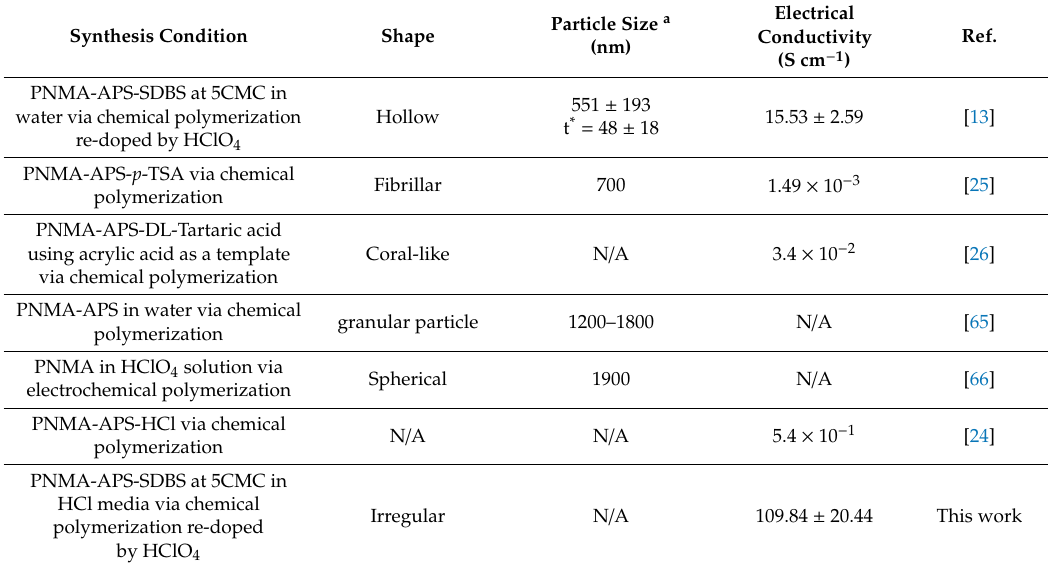
Table 2. Comparison between σ values, shape, and particle size of the synthesized PNMA in this work and previous